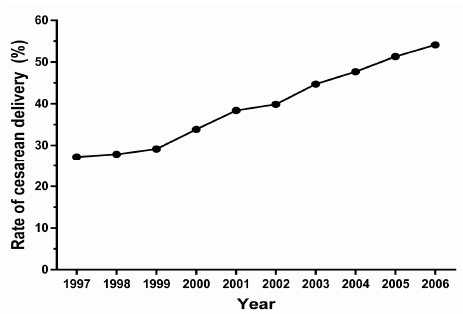
Figure 2. Secular trend in the rate of cesarean section during 1997–2006 in China.